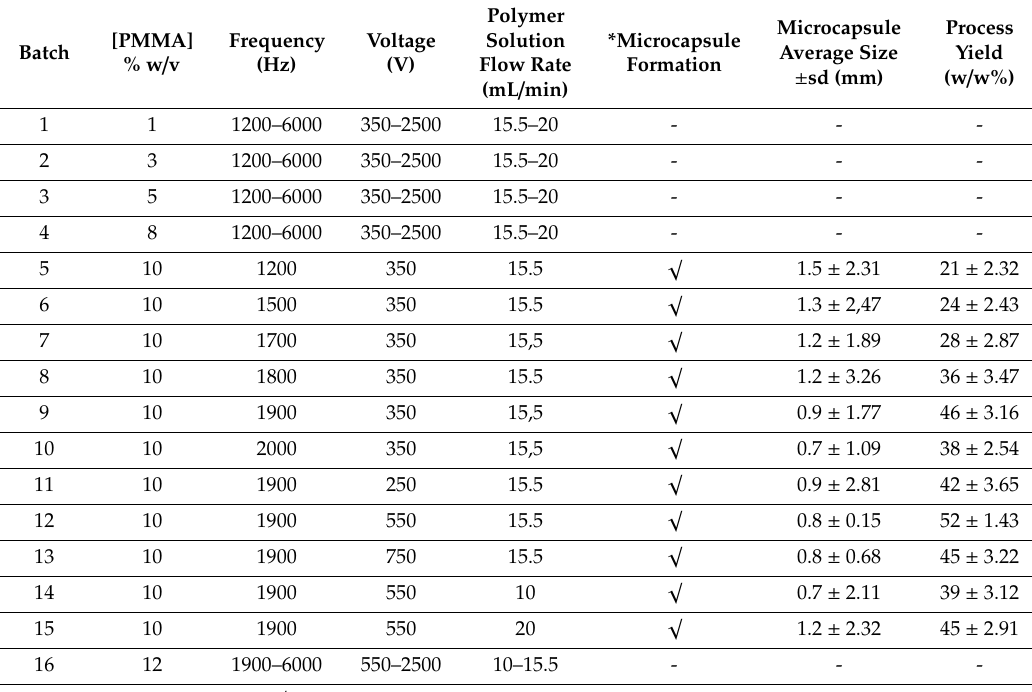
Table 2. Results of microcapsule preparation using poly(methyl-methacrylate) (PMMA) / MC solutions and the di ff erent process parameters evaluated.